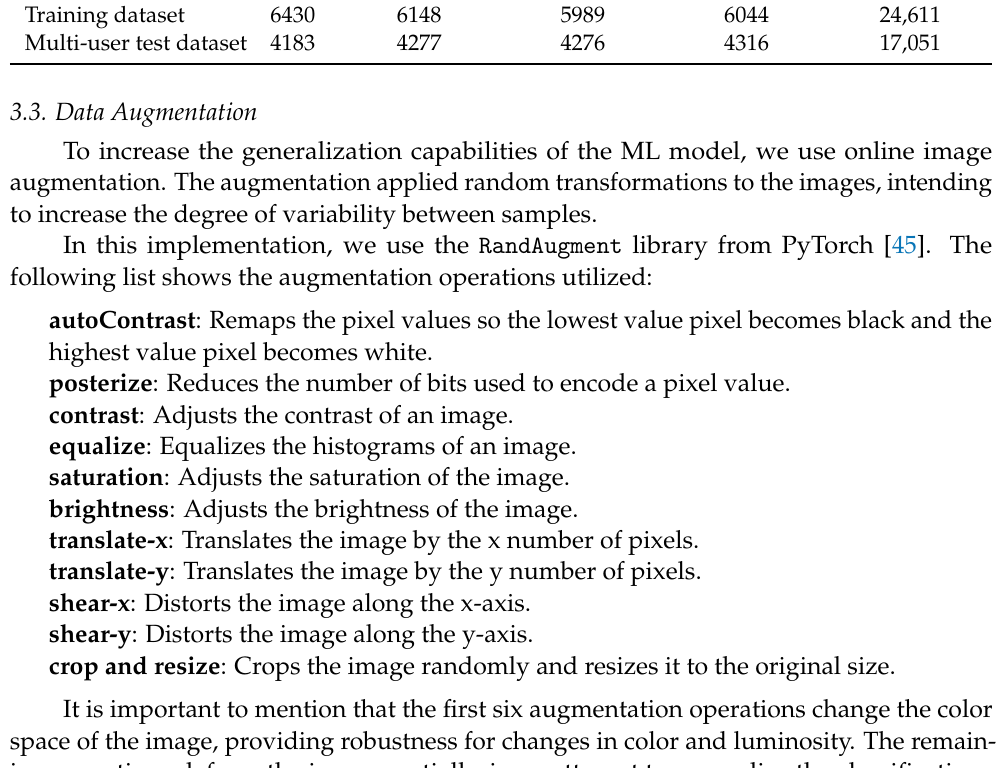
Table 1. Number of images, per class, of the training dataset, and the multi-user test dataset. The training dataset includes one user and the test dataset includes three users. Dataset A F L Y Total Training dataset 6430 6148 5989 Multi-user test dataset